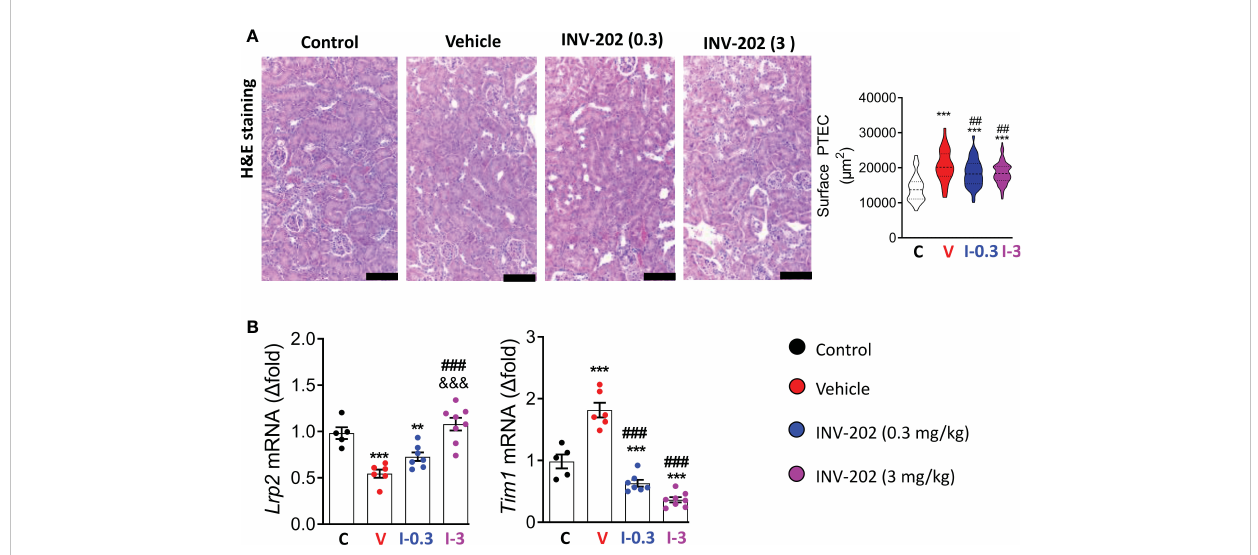
FIGURE 5 INV-202 treatment effects on proximal tubule cells. (A) Representative H&E staining of kidney slides with analysis of mean surface area of PTECs (scale: 100 µm). (B) mRNA analysis of Lrp2 and Tim1 coding for megalin and KIM1, respectively. Statistical signi fi cance versus nondiabetic control: **p < 0.01; ***p < 0.001; versus vehicle: ##p < 0.01; ###p < 0.001; versus INV-202 group, 0.3 mg/kg: &&&p < 0.001. H&E, hematoxylin and eosin; KIM1, kidney injury molecule 1; PTEC, proximal tubular epithelial cell. C: non-diabetic control mice, V: Vehicle-treated diabetic mice, I-0.3: INV-202- treated diabetic mice (0.3 mg/kg), I-3: INV-202-treated diabetic mice (3